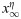
Power-law dynamics of individual Hodgkin-Huxley gating variables.(A) The response of the individual gating variables (n, m, and h) using the analytical (solid) and numerical (dotted) solutions to an identical voltage command (30 mV for n, -55 mV for m, -70 mV for h) with different values of the fraction order derivative (η). (B) The long term response of the individual gates (x∞η, x = m,n or h) for all the voltages and values of η for the analytical and numerical solutions. The arrow points to the inflection point of the sigmoidal curve. For m∞0.2 some numerical solutions were unstable. (C) For the n and h gates we fitted a dual exponential process to the temporal response to voltage commands for all values of η resulting in a fast and slow time constant (τxη, x = m, n, or h). We fitted a single time constant to the m gate.